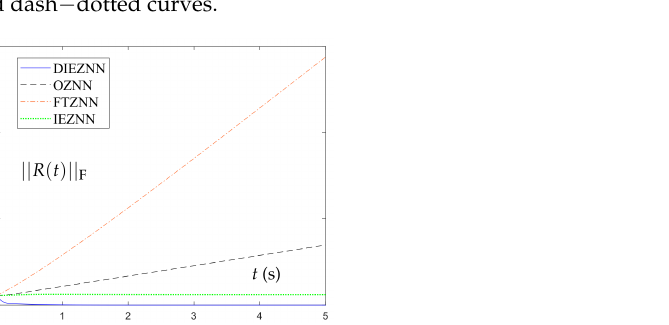
Figure 3. State trajectories of the DIEZNN model (Equation (14)), OZNN model (Equation (5)), FTZNN model (Equation (8)) and IEZNN model (Equation (11)) for solving Equation (1) under linear noise N ( t ) = 10 + 10 t . When the design parameters γ = 5, the neural − state solutions to the DIEZNN model (Equation (14)), OZNN model (Equation (5)), FTZNN model (Equation (8)) and IEZNN model (Equation (11)) are represented by blue solid curves, black dashed curves, orange dash − dotted curves and green dotted curves, respectively. The theoretical solution is represented by red dash − dotted curves.